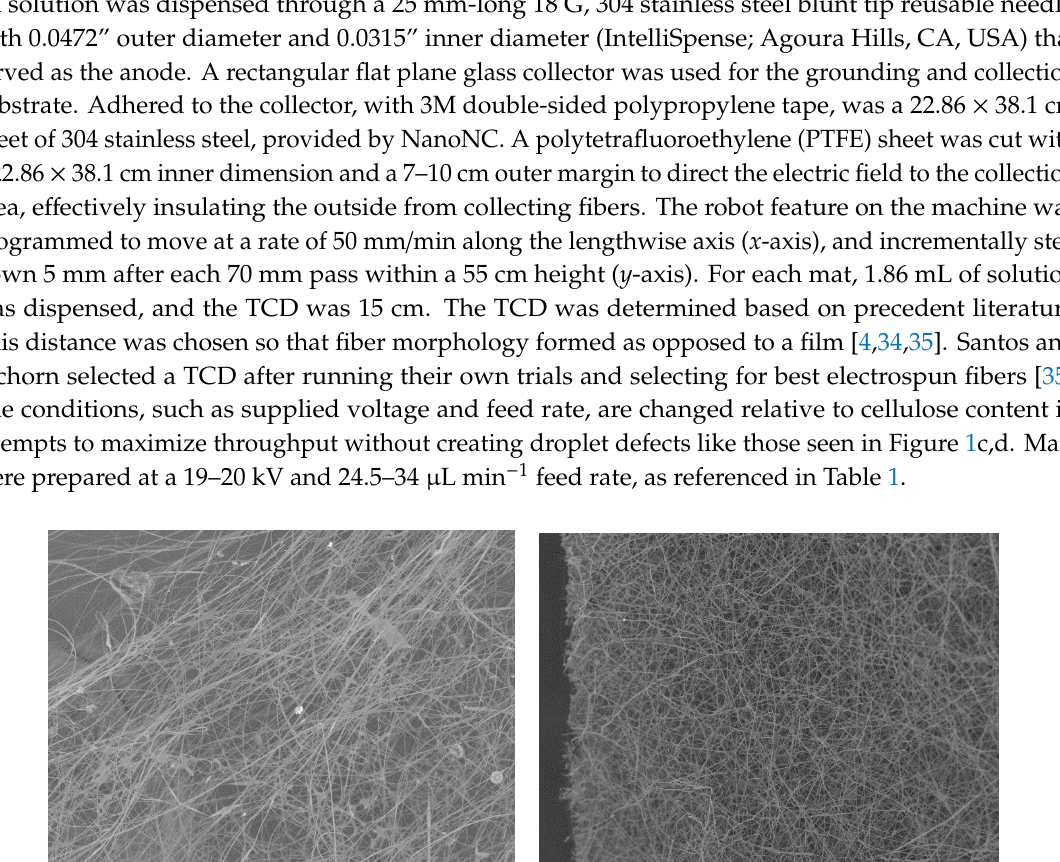
Table 1. The voltage supplied (kV) for the electrospun mats, the conductivity ( µ S / cm) of each solution and feed rate ( µ L min − 1 ) for each mat type. The sample code is explained in Section